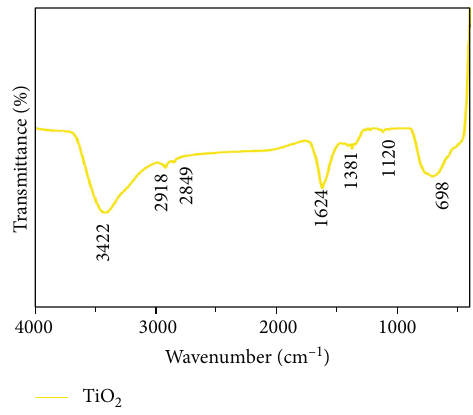
Figure 6: Biosynthesized TiO